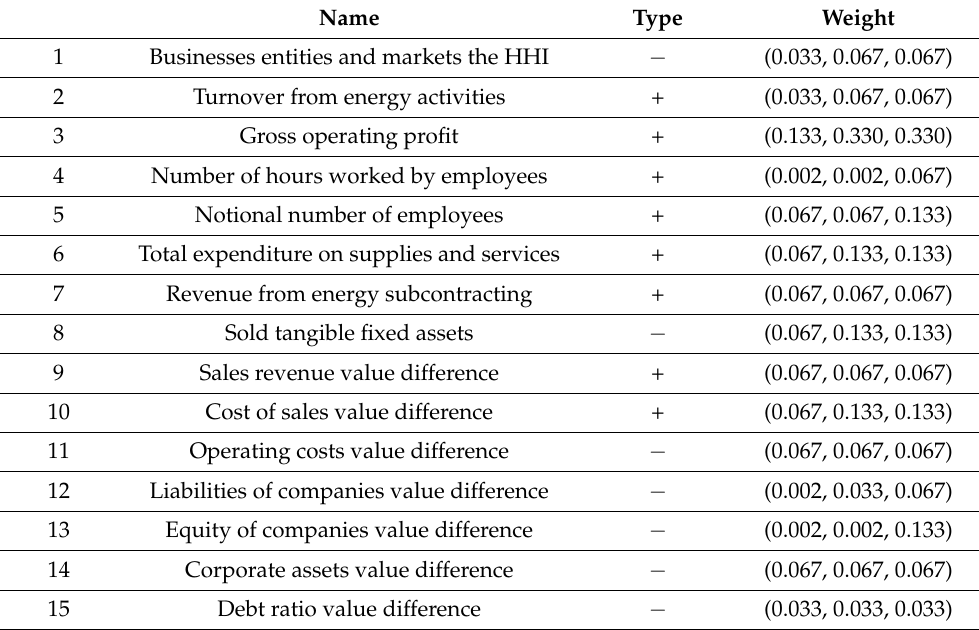
Table 1. Criteria arithmetic mean of all experts.